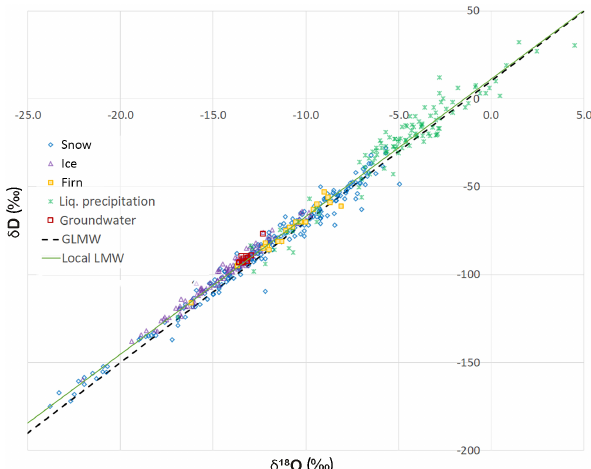
Figure 7. δ 18 O vs. δ D graph for the samples of snow, ice, firn, liq- uid precipitation, and groundwater collected in the Djankuat River basin in 2013–2017, plotted with a global and local meteoric water